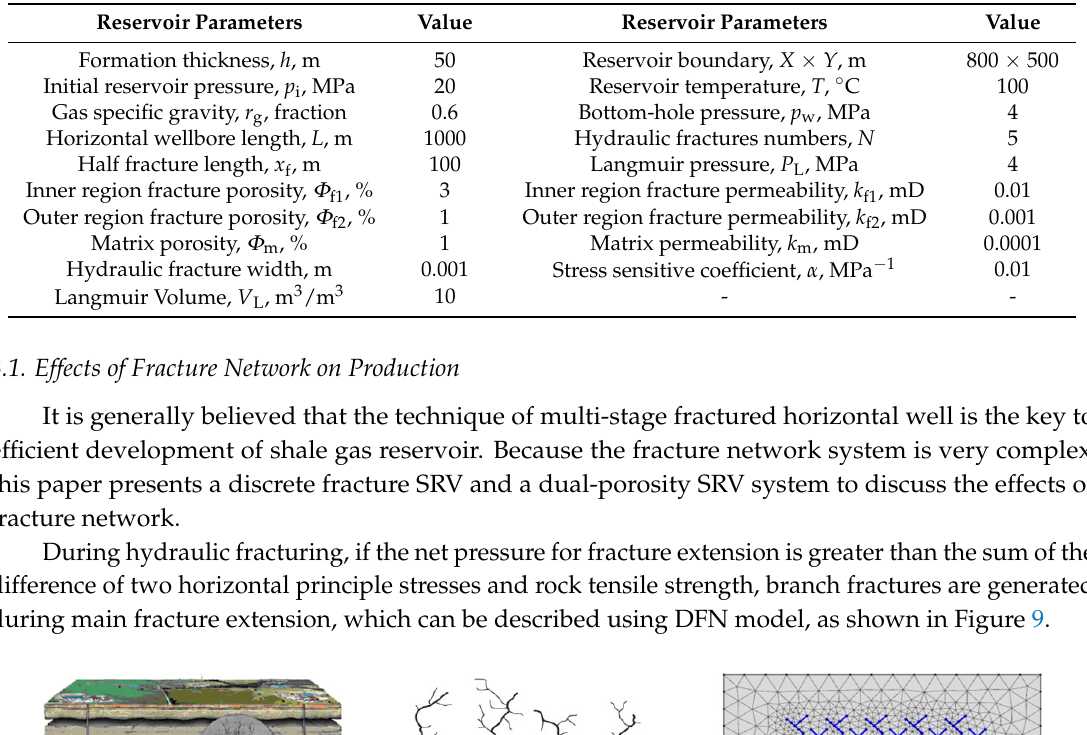
Figure 10. Dual-porosity model of a fracture network system in shale. Figure 11 compares the production rate curves of unconventional reservoirs and conventional homogeneous reservoir. At the beginning of production, high conductivity fracture network means more flow paths from reservoir to wellbore, which results in a higher production. At the latter part of production, it can be seen from the pressure distribution figures (Figure 12) that either dual-porosity model or discrete fracture model can form a large low pressure region, which improves the desorption gas production as well as reduces the flow resistance to the well.